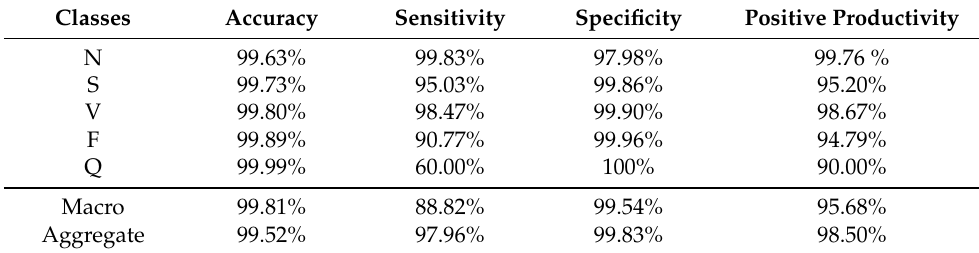
Table 5. Classification results for the intra-patient